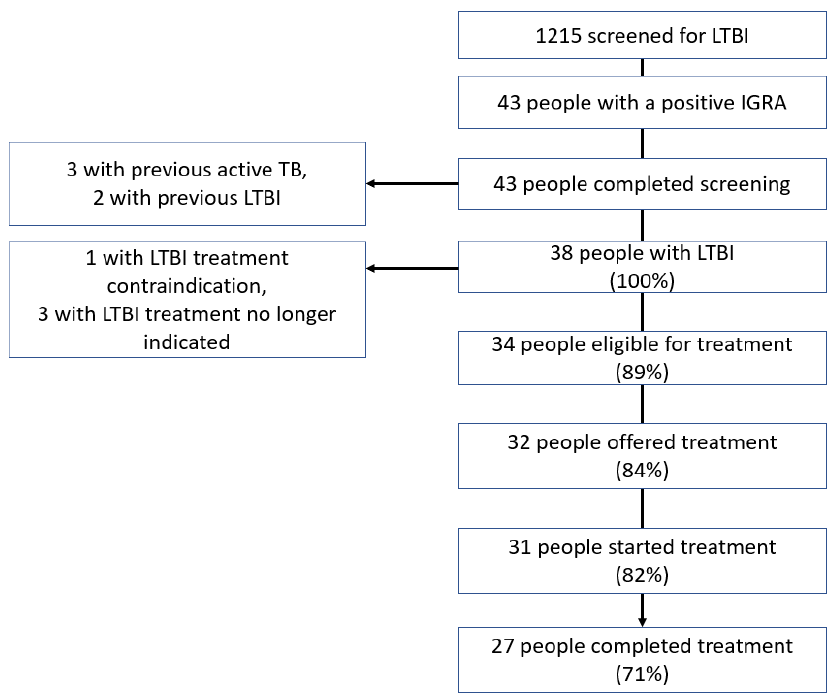
Figure 2. Cascade of interferon-gamma release assay testing performed to screen for latent tuberculosis infection.